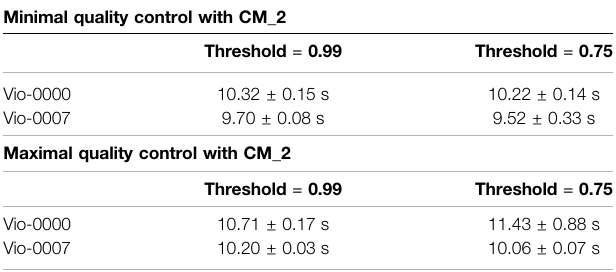
TABLE 2 | Performance of the CM_2 Algorithm. Performance was assessed for constructs of opposite complexity and different reconstruction thresholds. Results in the top part of the table are for the minimal QC scenario, and show computation times are unaffected by the constructs and threshold. Results in the bottom part of the table are for the maximal QC scenario, and also show computation times are unaffected by the constructs and threshold. Minimal quality control with CM_2